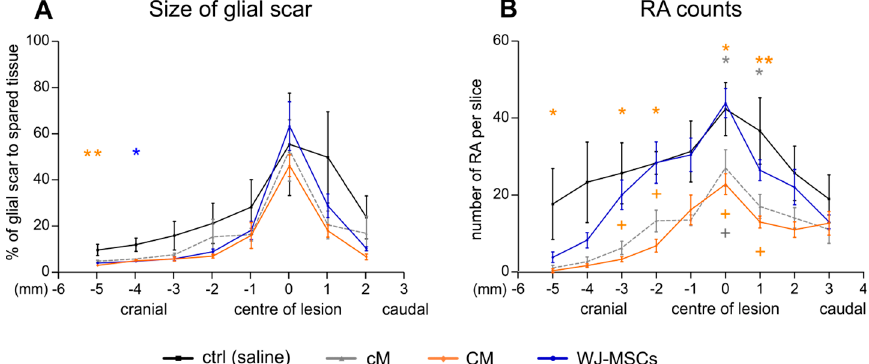
Figure 5. Glial scar formation analyses. ( A ) The size of glial scar expressed as the % to spared tissue. ( B ) Number of reactive astrocytes (RA) counted from the glial fibrillary acidic protein (GFAP) staining as shown in Figure 6. Number of animals: Saline treated control group n = 4, cM group n = 5, CM group n = 5 and WJ-MSCs group n = 5. Asterisks (*) show statistical significance of particular treatment, when compared to saline treated control group, crosses marks ( + ) show statistically significant di ff erence between WJ-MSCs group and CM group (orange cross) and between WJ-MSCs group and cM group (gray cross), respectively. * p < 0.05, ** p < 0.01 and + p < 0.05.